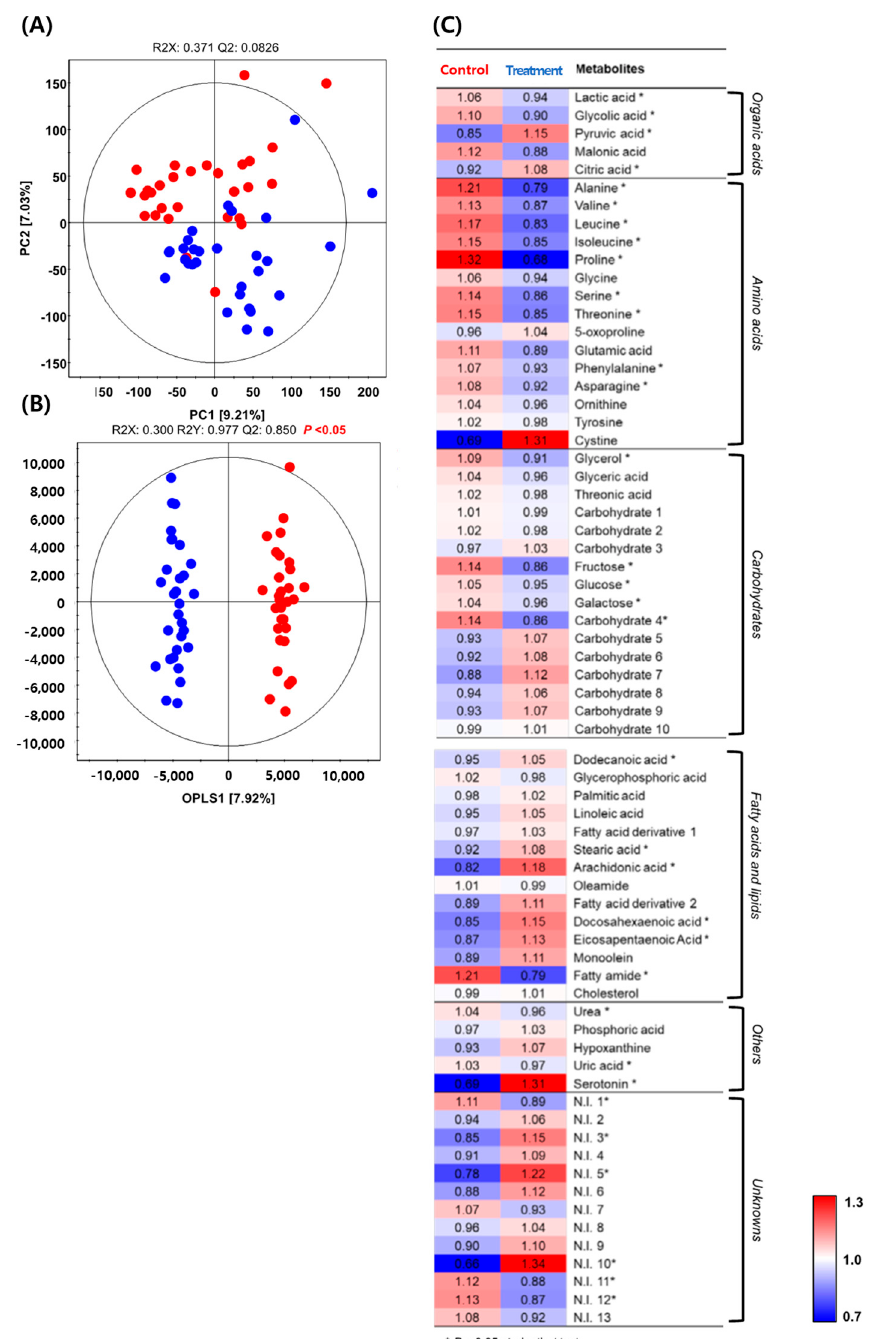
considered as the major neurotransmitter involved in human emotions and mood, showed significantly higher contents in the SS sample ( p < 0.05).